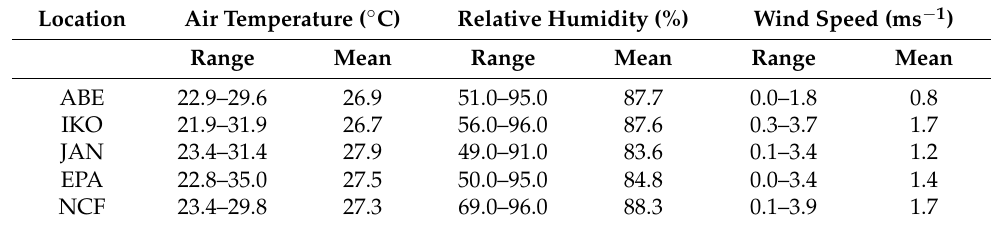
Table 3. Summary of diel changes in local Lagos meteorology.